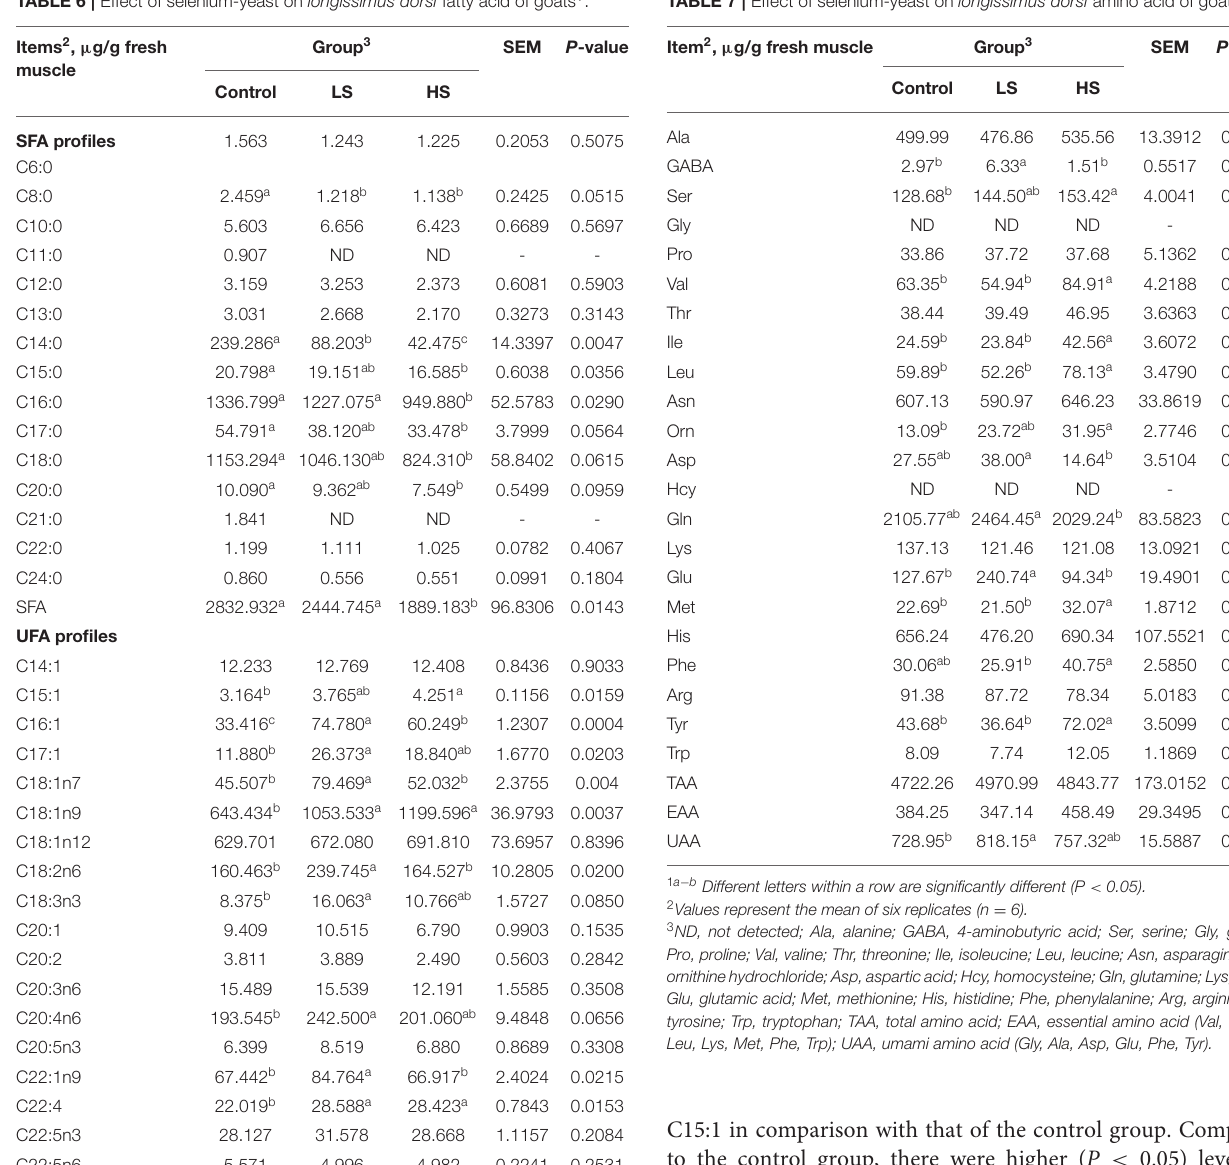
TABLE 7 | Effect of selenium-yeast on longissimus dorsi amino acid of goats 1